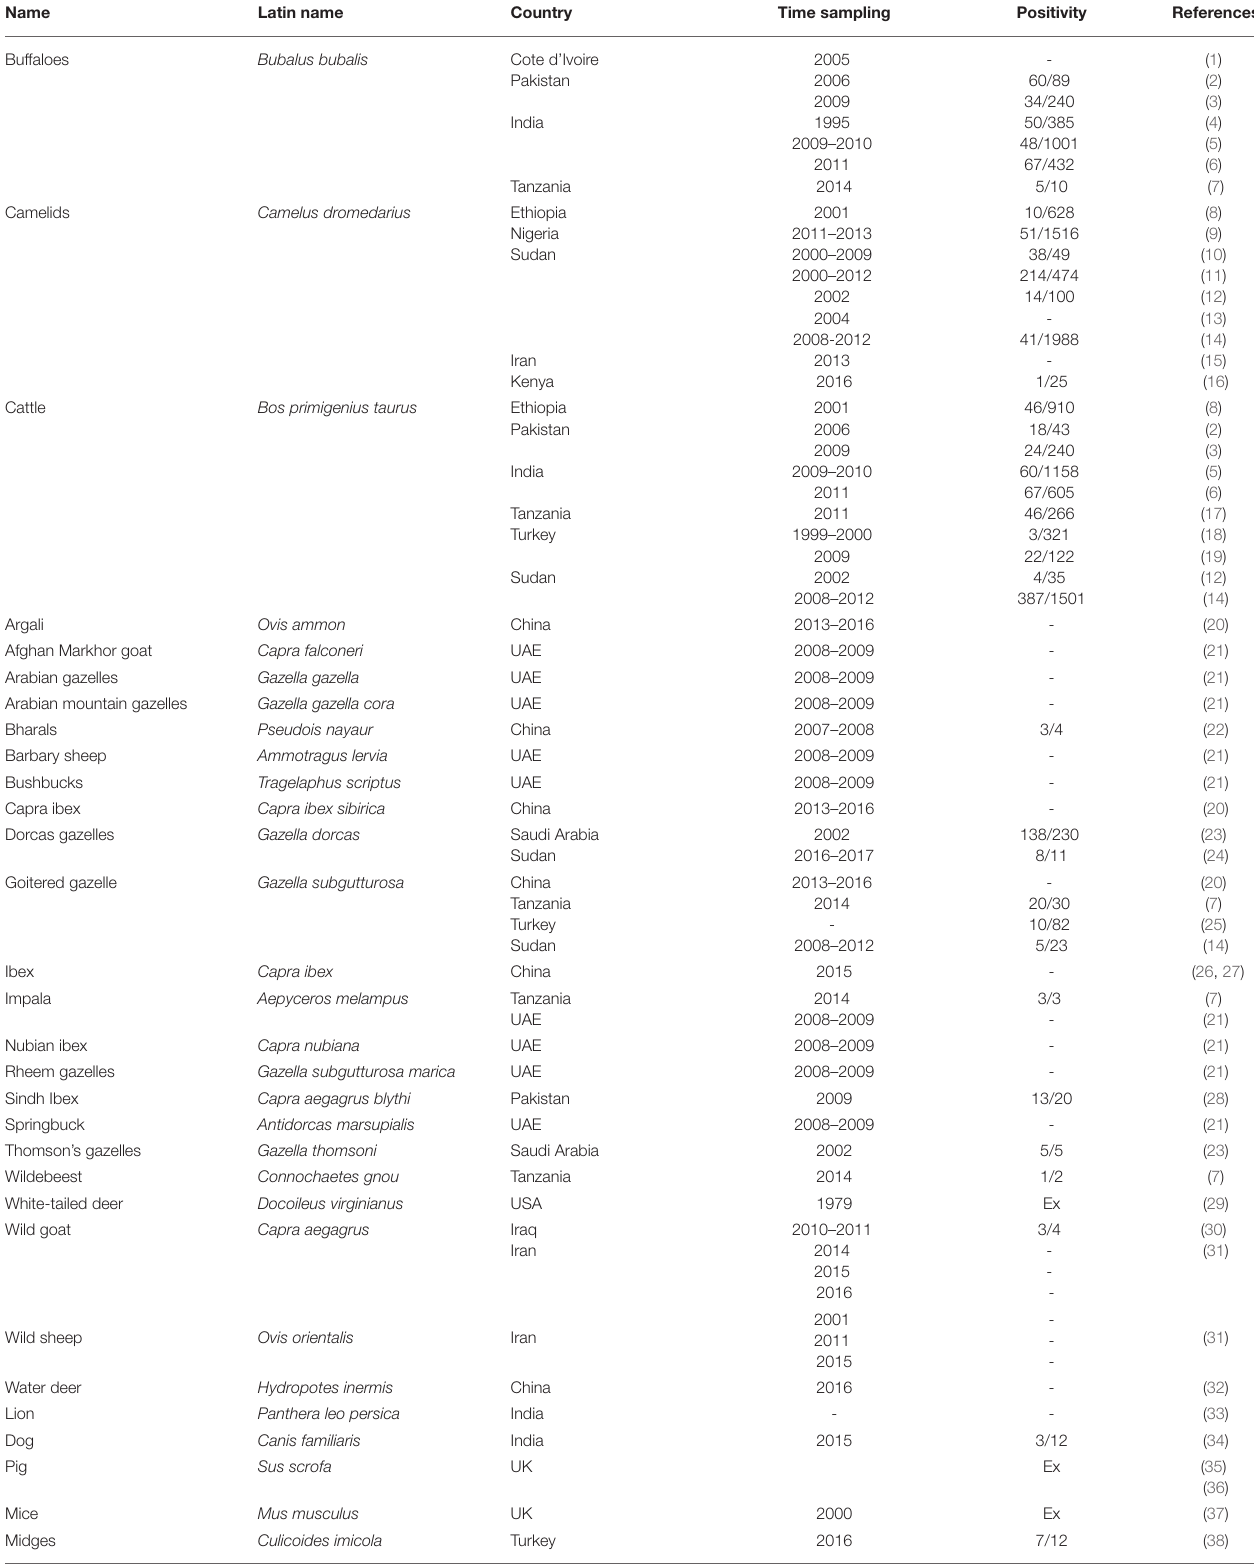
TABLE 1 | PPR infection cases in diverse animals except domestic small